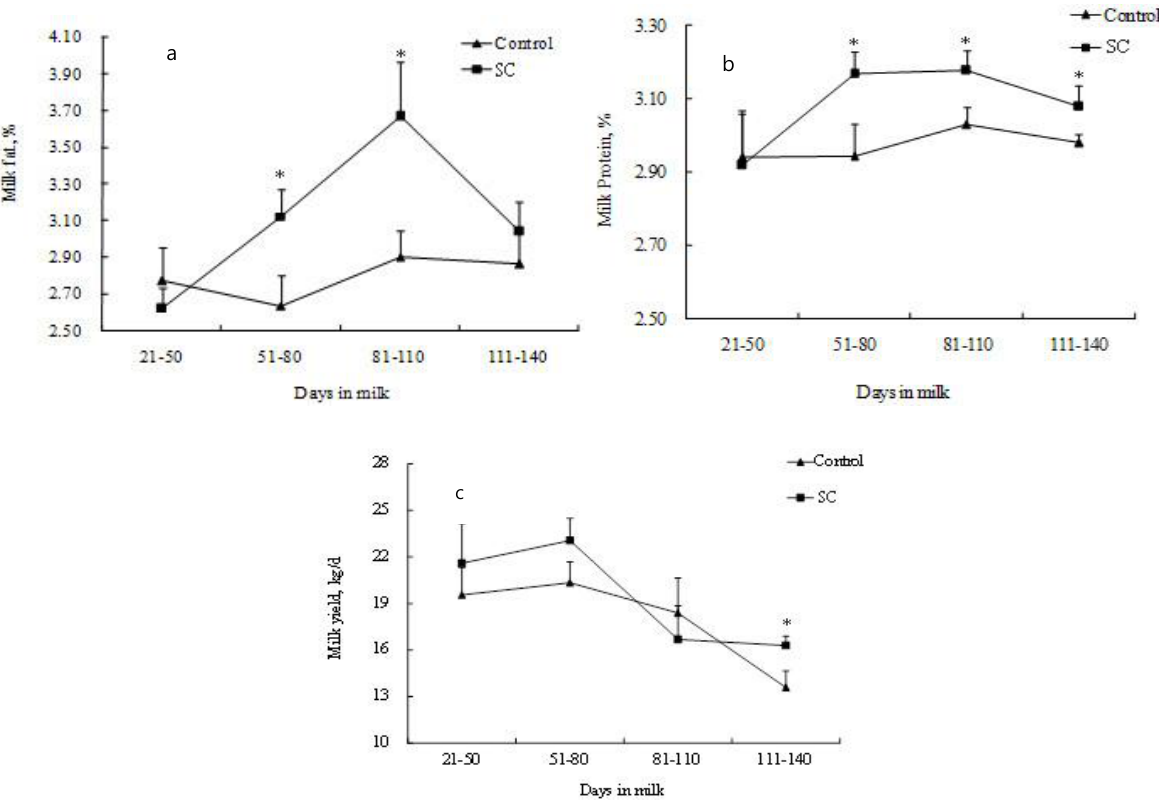
Figure 2. Interaction between SC and DIM on percentage of milk fat (a) and milk protein (b), and milk yield (c) (Farm 2). SC was fed at 56 g/cow/d (Diamond V Original XP, Diamond V, Cedar Rapids, Iowa, USA). Note: symbols on the top of standard error bars indicate the significance of the differences between data for control and SC